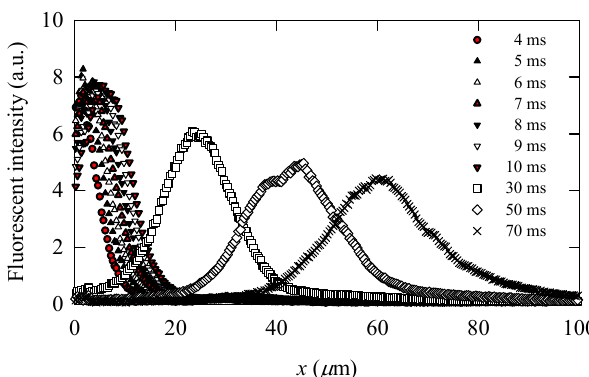
Figure 6. Fluorescent intensity profiles of electroosmotic flow in time series at y = 50 µ m obtained from EWMT using the CMOS camera. An electric field of 333 V/cm was applied. Measurement was performed just after 74 ms of the UV laser exposure, thus, for example, 4 ms corresponds to t = t + 4 ms ( t = 74 ms). 0 0